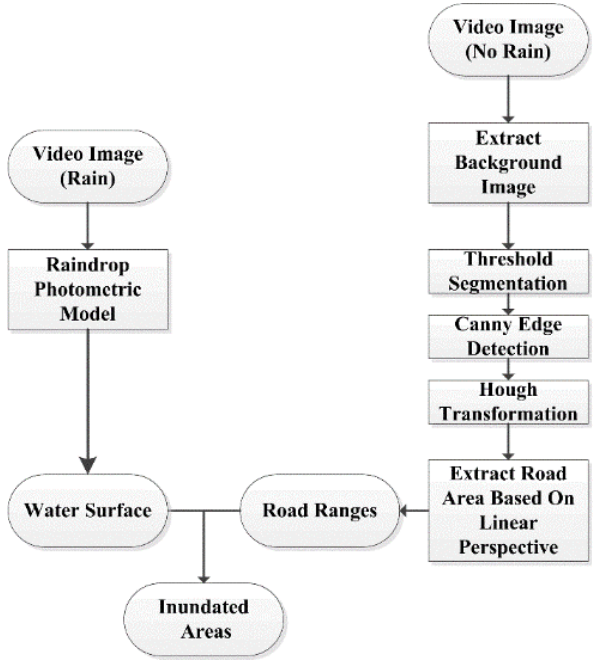
Figure 1. Flowchart of inundated areas extraction.